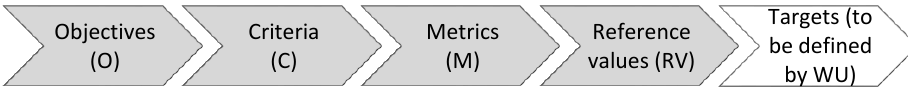
Figure 2. Stages for the construction of the PAS and main results.